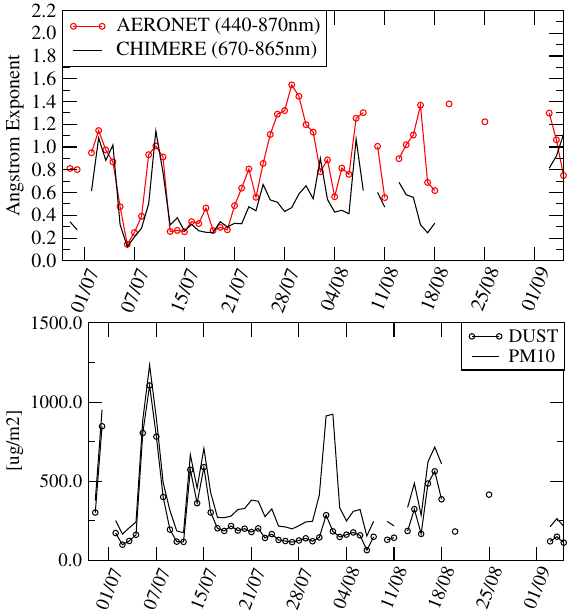
Fig. 10. Temporal evolution of the daily mean and Angstr¨om exponent (440–870 nm ) for the AERONET station in Blida (2.88 ◦ E, 36.5 ◦ N) between 29 June and 6 September 2007 and the corresponding CHIMERE Angstr¨om exponent (at 670–865 nm , red line). The daily mean (for the same hours as the measurements) dust and PM 10 concentrationis shown in the bottom figure.